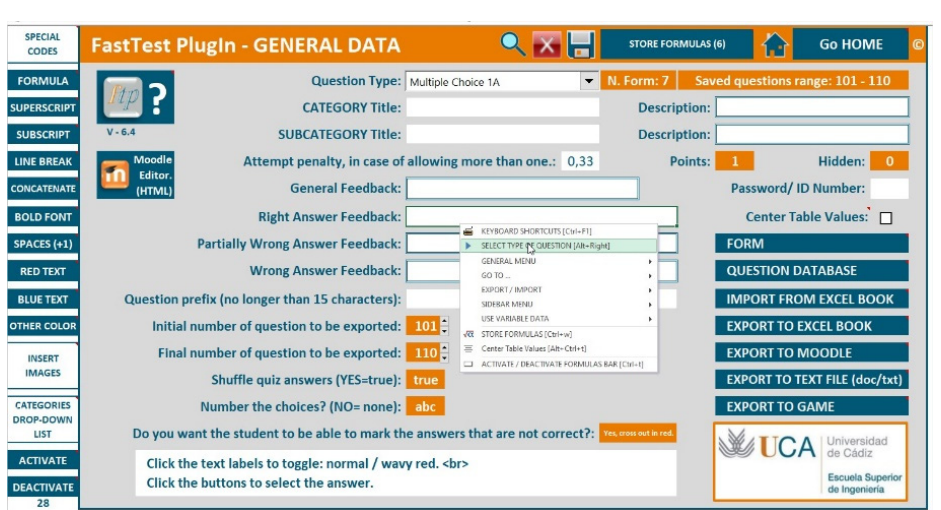
Figure 3. The “General Data” interface.